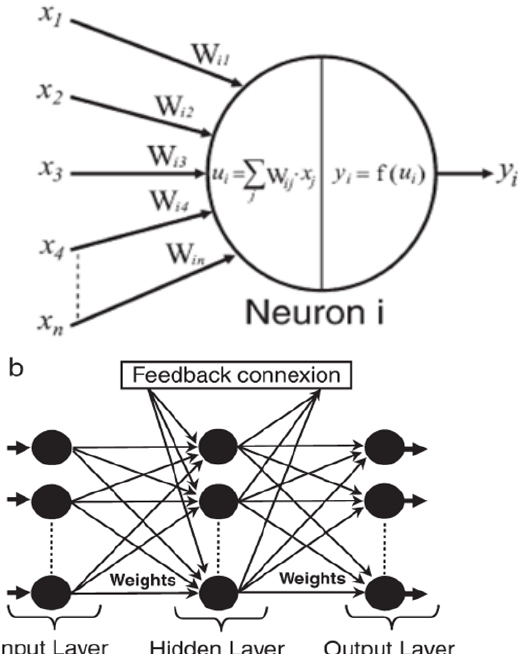
Fig. 2. General topology of a feed-forward ANN with one hidden layer.